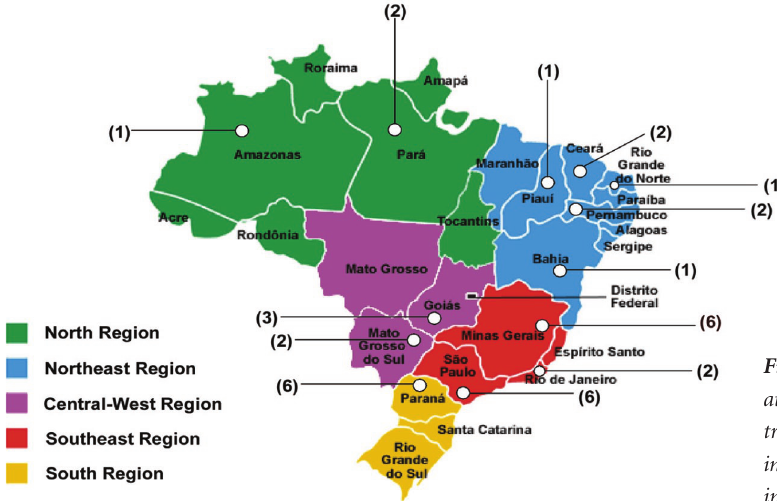
Figure 1. The notified cases for possible CJD evalu- ated by biochemical and/or genetic markers were dis- tributed throughout the Brazilian territory. Numbers in brackets represent the quantity of reported patients in the state